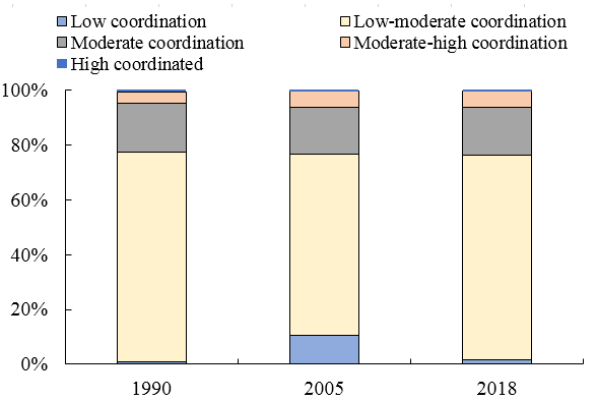
Figure 6. Histogram of evaluation results of land spatial function coordination degree in Henan Province from 1990 to 2018.